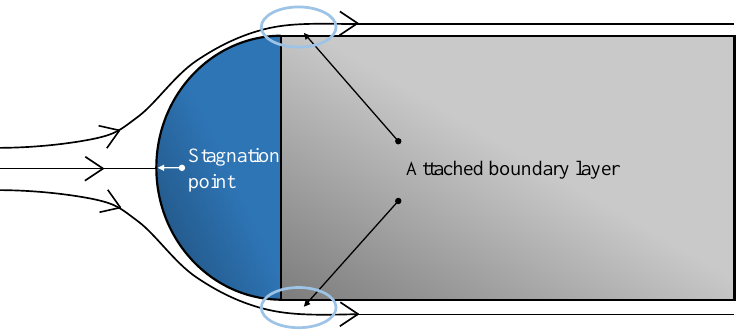
Figure 4. Stagnation point position and expected flow streamlines for the considered geometry under an axial